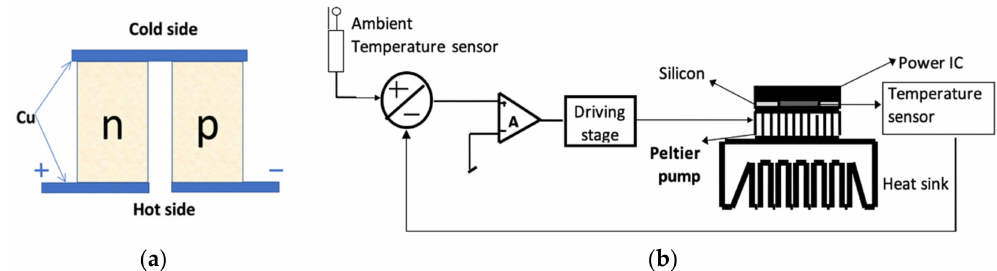
Figure 1. ( a ) Singular Peltier cell (n,p—semiconductors, e.g., Be 2 Te 3 ); ( b ) classical feedback loop in active heat sink control